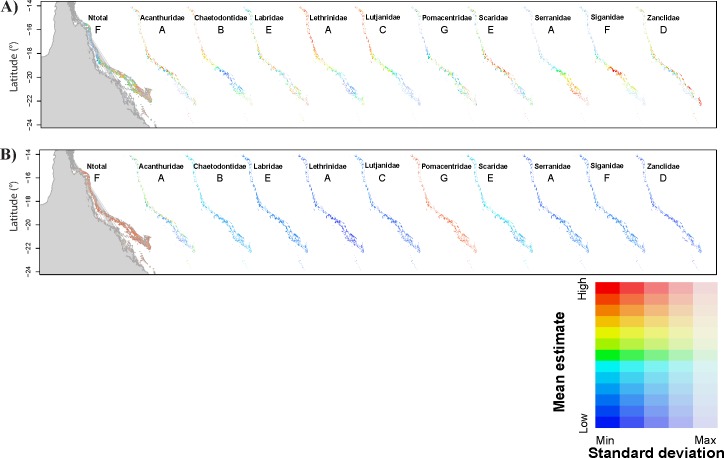
Predictions of total fish abundance (Ntotal) and fish abundance by fish family to the Great Barrier Reef by the GBR models.Results for each family shown for a representative scenario only (indicated by letter from A to G). Refer to Fig. S1, for predictions from all GBR scenarios. (A) showing maximum and minimum values for each map independently, and (B) reflecting ranges of values across all maps highlighting Pomacentridae as the most abundant fish family, but also with large prediction error (refer to Tables 2 and 3). Predicted minimum and maximum abundance values for each scenario shown here were: 173–958 (Ntotal), 3–99 (Acanthuridae), 25–51 (Chaetodontidae), 4 –13 (Labridae), 2–6 (Lethrinidae), 2–11 (Lutjanidae), 273–725 (Pomacentridae), 10–50 (Scaridae), 2–8 (Serranidae), 1–10 (Siganidae), and 1–8 (Zanclidae). Grey area represents Queensland in the Northeast of Australia, longitude: 141° to 153°E.